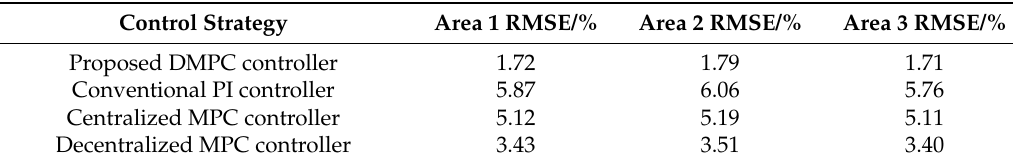
Table 4. Frequency deviation RMSE comparisons in each area.